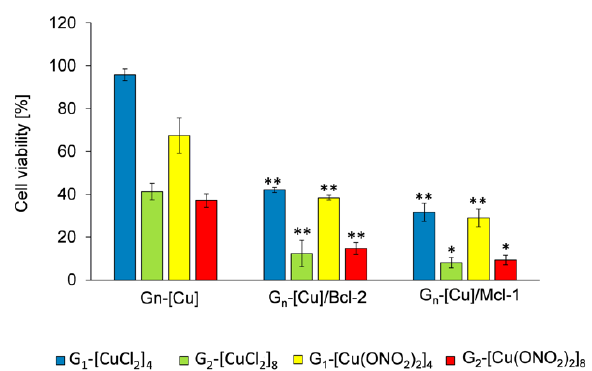
Figure 9. Viability of MCF-7 cells after 72 h of incubation with G n -[Cu] and their complexes with pro-apoptotic siRNAs (Mcl-1; Bcl-2) at molar ratio [G n -[Cu]]/[siRNA] = 30. Conditions: [G n -[Cu]] = 3 μM, [siRNAs] = 100 nM. Results are mean ± standard deviation (SD), n = 3. Statistically significant differences compared to the control cells p ≤ 0.05 (*); p ≤ 0 .01 (**); p ≤ 0 .001 (***).